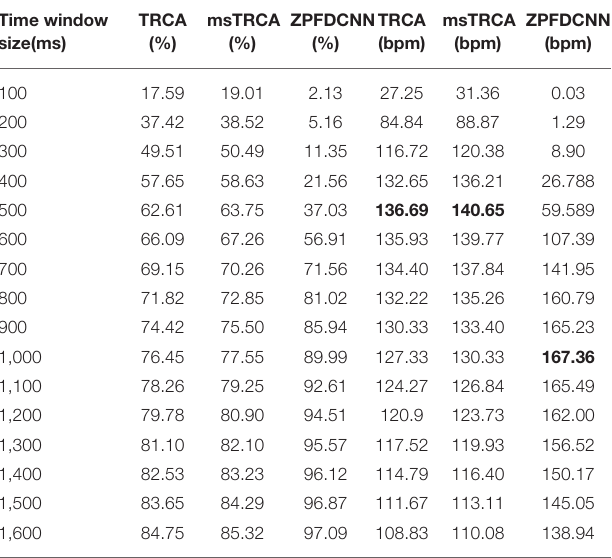
TABLE 2 | Average classification accuracy and ITR of the BETA:SSVEP dataset with a visual shift time of 0.55 s. Time window